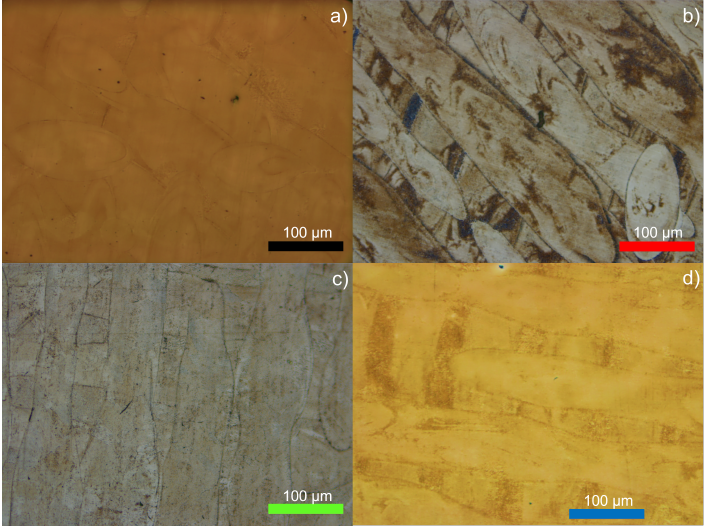
Figure 8. Micrographies of the etched surfaces of 316L ( a ), 630 ( b ), 420 ( c ) and 440C ( d ) stainless